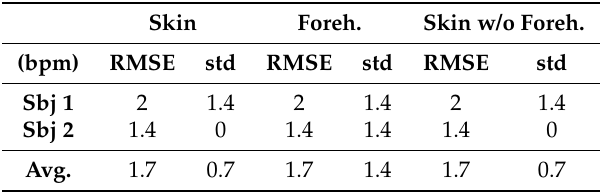
Table 8. Comparison of heart rate estimation between signal extracted with deep learning-based facial skin detection ( Skin ) versus classical face detection method ( Foreh. ). Skin Foreh. Skin w/o Foreh. (bpm) RMSE std RMSE std RMSE std Sbj 1 2 1.4 1.4 1.4 Sbj 2 1.4 1.4 1.4 1.7